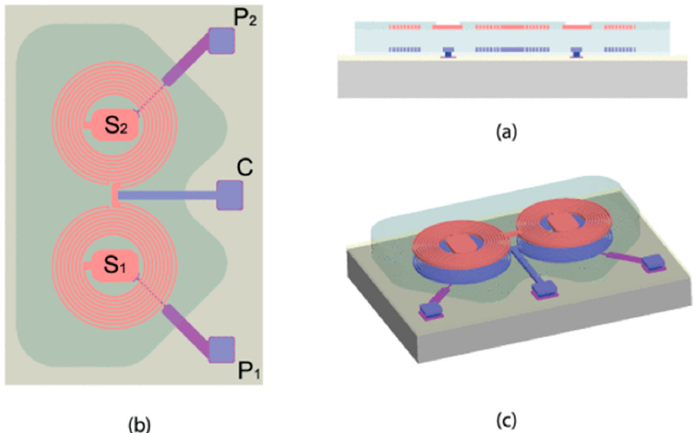
Figure 6. Isolation polyimide transformer. ( a ) Cross-section. ( b ) Top-view. ( c ) Three-dimensional view. Reproduced from [20]. Copyright 2016, IEEE.